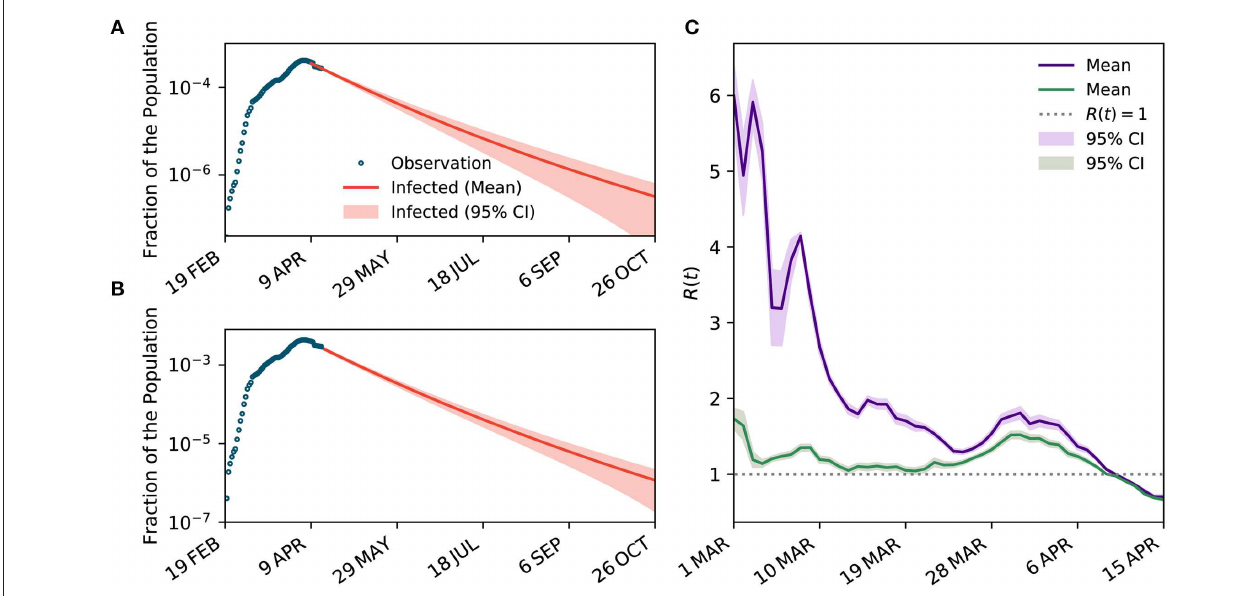
FIGURE 4 | The impact of underreporting on the estimated dynamics of transmission. (A,B) The projected curves for the number of infected cases when underreporting is not considered and when it is taken into account, respectively. (C) Temporal variations of R ( t ) when underreporting is overlooked (purple curve) and when it is taken into account (green